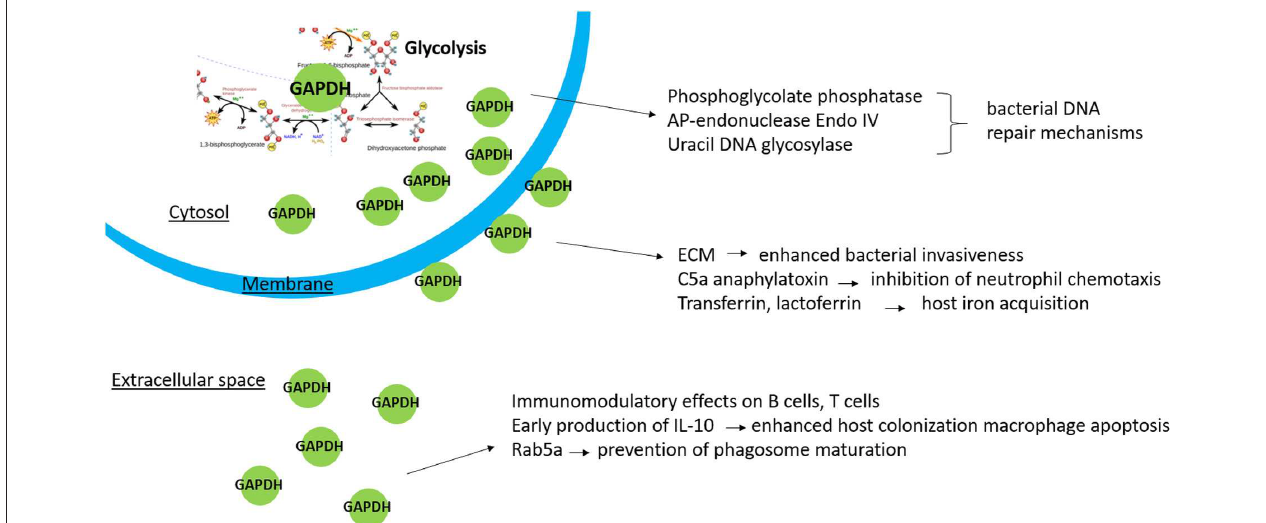
FIGURE 1 | Non-enzymatic functions of bacterial GAPDH in relation to its localization.